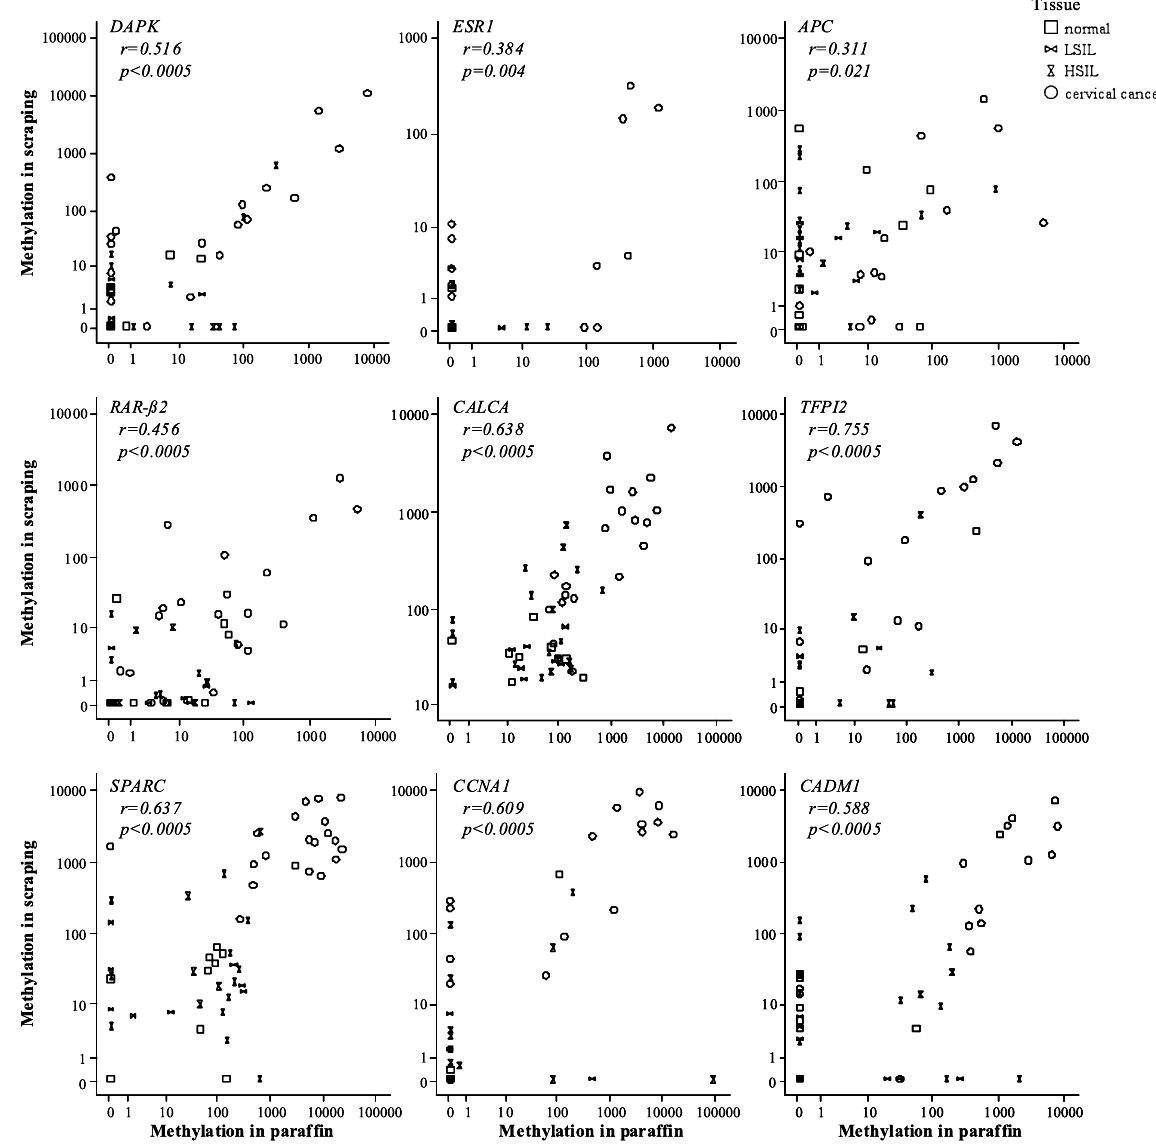
Fig. 2. Methylation ratios determined in paraffin tissue in comparison to the methylation ratio determined in the scraping of the same patient subdivided in the different tissue